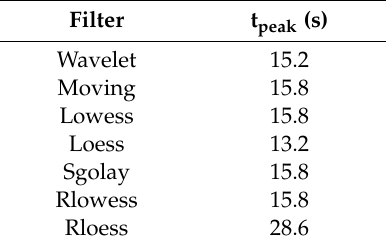
Table 2. Calculated travel time values t peak